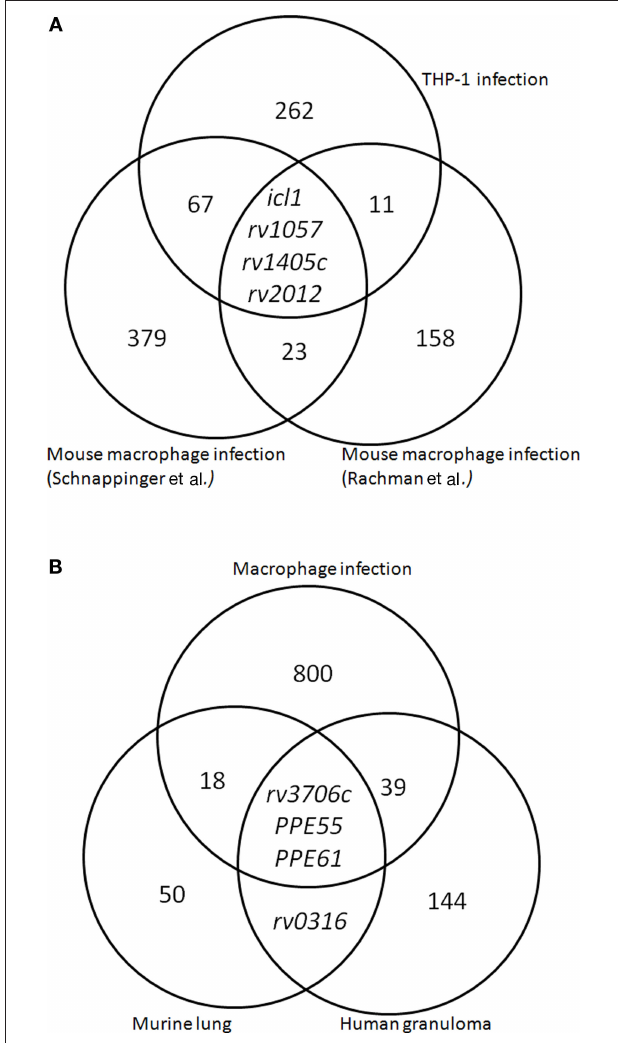
FiGuRe 1 | Meta-analysis of M. tuberculosis transcriptomes using variable models of infection. (A) Macrophage expression data following infection with M. tuberculosis reveals overlap of upregulated genes identified in three macrophage models of M. tuberculosis infection (Schnappinger et al., 2003; Rachman et al., 2006a; Fontán et al., 2008). (B) Expression data in three models of tuberculosis infection, including ex vivo macrophage infection, mouse infection, and profiling of infected human lung tissue (Schnappinger et al., 2003; Talaat et al., 2004; Rachman et al., 2006a,b; Fontán et al.,